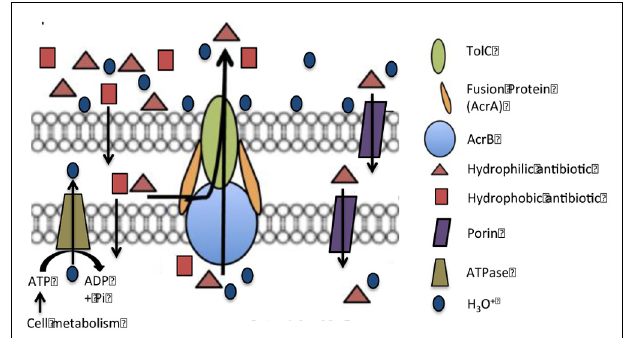
FIGURE 1 | Model of theAcrAB-TolC efflux pump of a Gram-negative bacterium. Hypothesis. At near neutral pH, hydronium ions from hydrolysis of ATP by ATP synthase pass through the AcrB transporter, reduce the pH to a point that causes the release of the substrate.When the hydronium ions reach the surface of the cell they are distributed over that surface and bind to lipopolysaccharides and basic amino acids.When there is a need for hydronium ions for activity of the efflux pump, the pH is lower than neutral and the hydrolysis of ATP is not favored, hydronium ions from the surface of cell due to the PMF move through the porins and reach the transporter where they are pushed through the transporter by the peristaltic action caused by the fusion proteins. Substrates bound to the transporter dissociate when the pH is reduced by the flow of hydronium ions and are carried out by the flow of